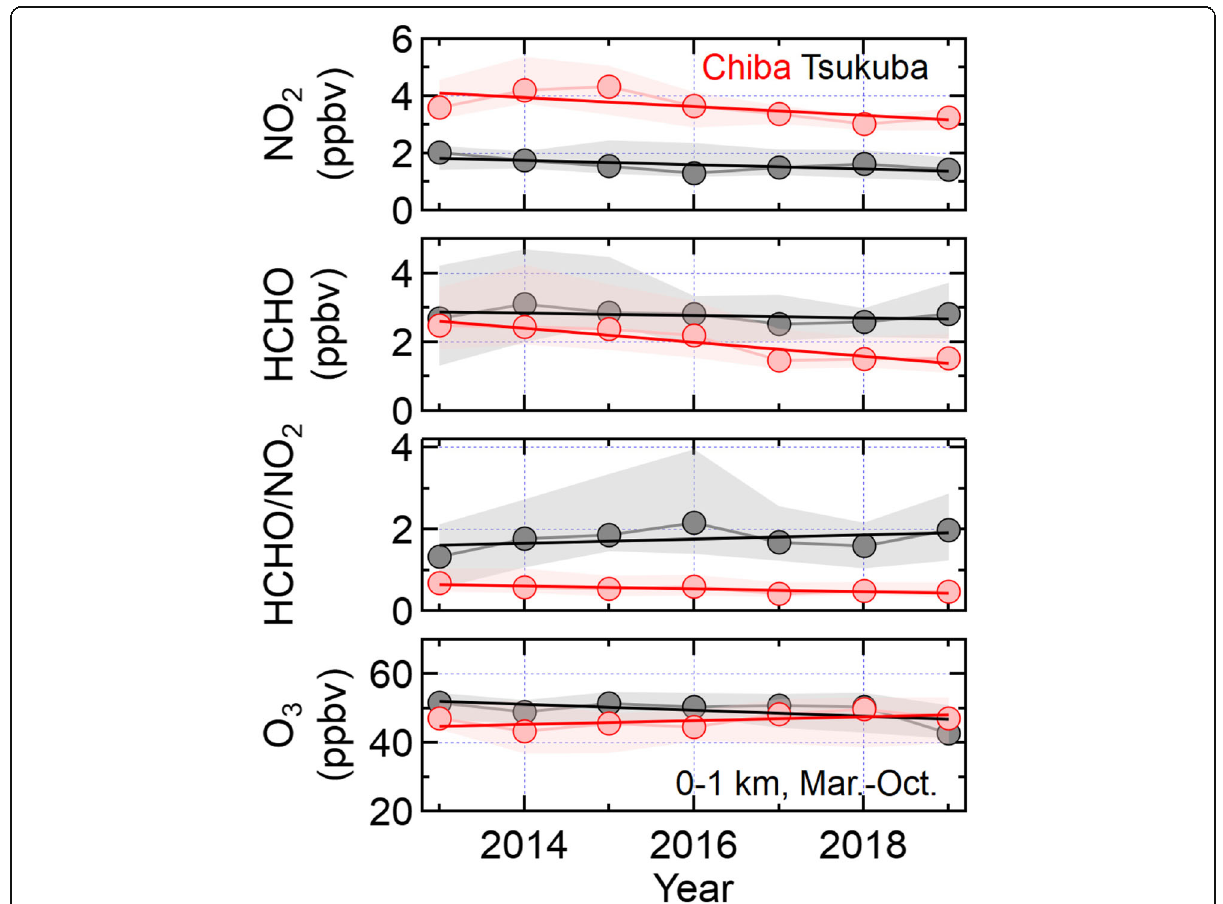
Fig. 5 Timeseries of NO 2 and HCHO concentrations, HCHO/NO 2 concentration ratio, and O 3 concentration for the lowest layer (altitude of 0 – 1 km) retrieved from MAX-DOAS observations at Chiba (red) and Tsukuba, Japan. The median values for the 8 months (March to October), when MAX-DOAS O 3 data were available, are shown for each year. Shaded areas represent 67%